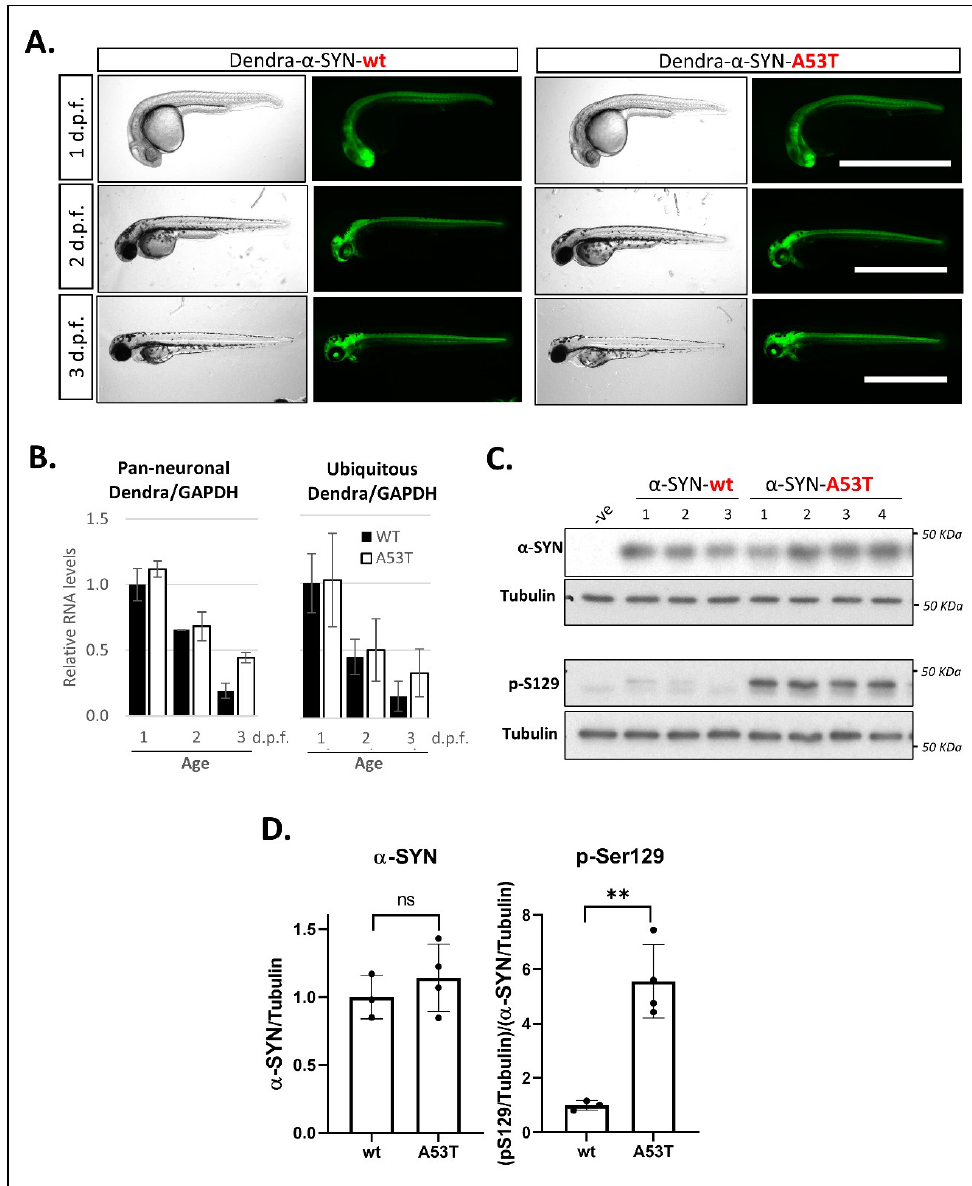
(Figure S1G). Crosses to the ubb :GAL4-VP16 driver fish also resulted in morphologically normal larvae from 1 to 3 d.p.f. (Figure S1H).